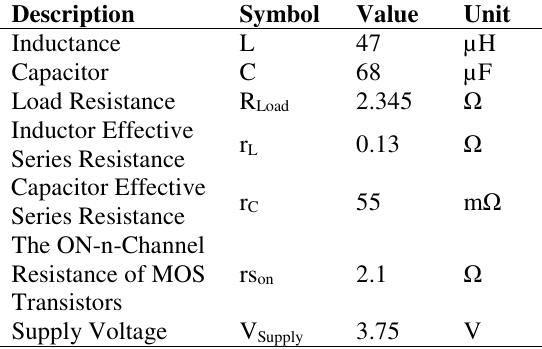
The parameter values of the Buck converter model [3,